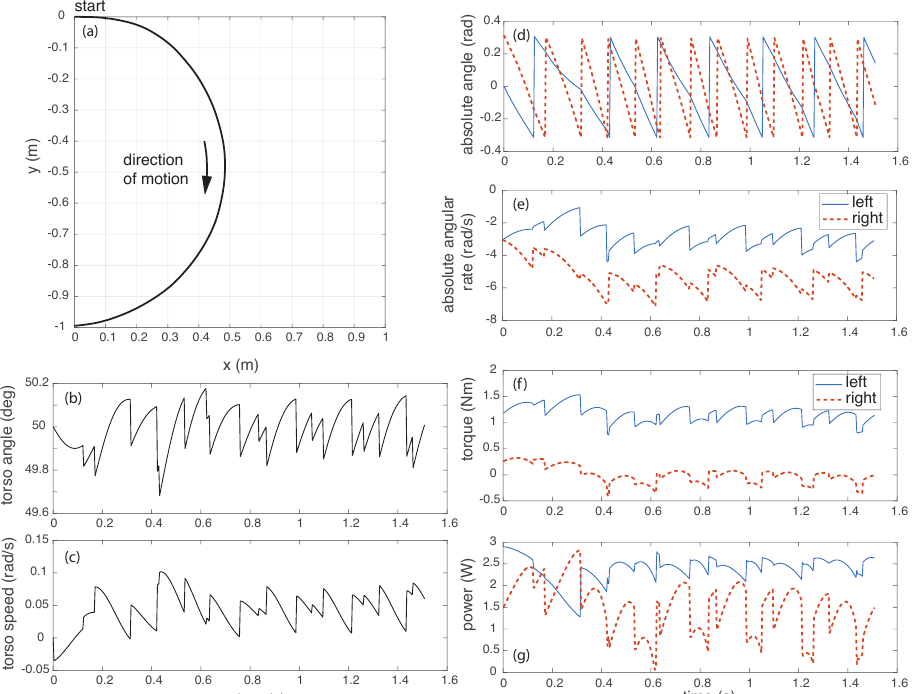
Figure 9. Simulation data for turning: ( a ) Trajectory for circular turn, ( b ) torso angle, ( c ) torso velocity, ( d ) absolute angle of the wheel, ( e ) absolute angular speed of the wheel, ( f ) torque on the torso, and ( g ) total motor